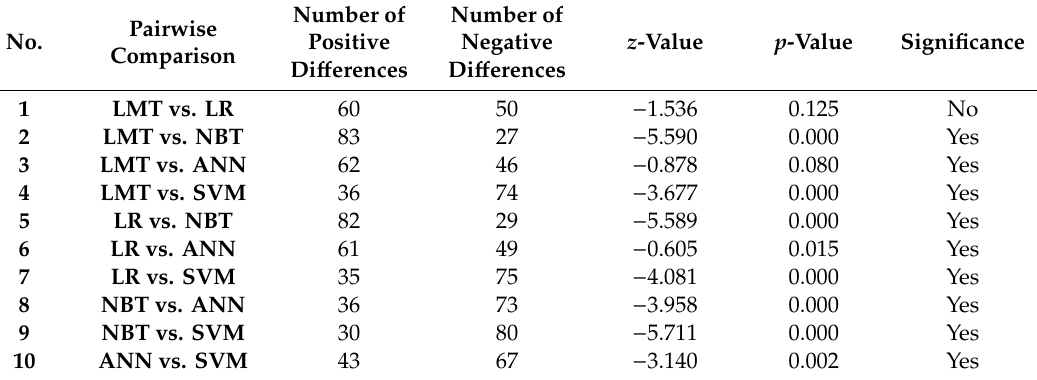
Table 3. Performance of the five landslide machine learning models using the Wilcoxon signed-rank test